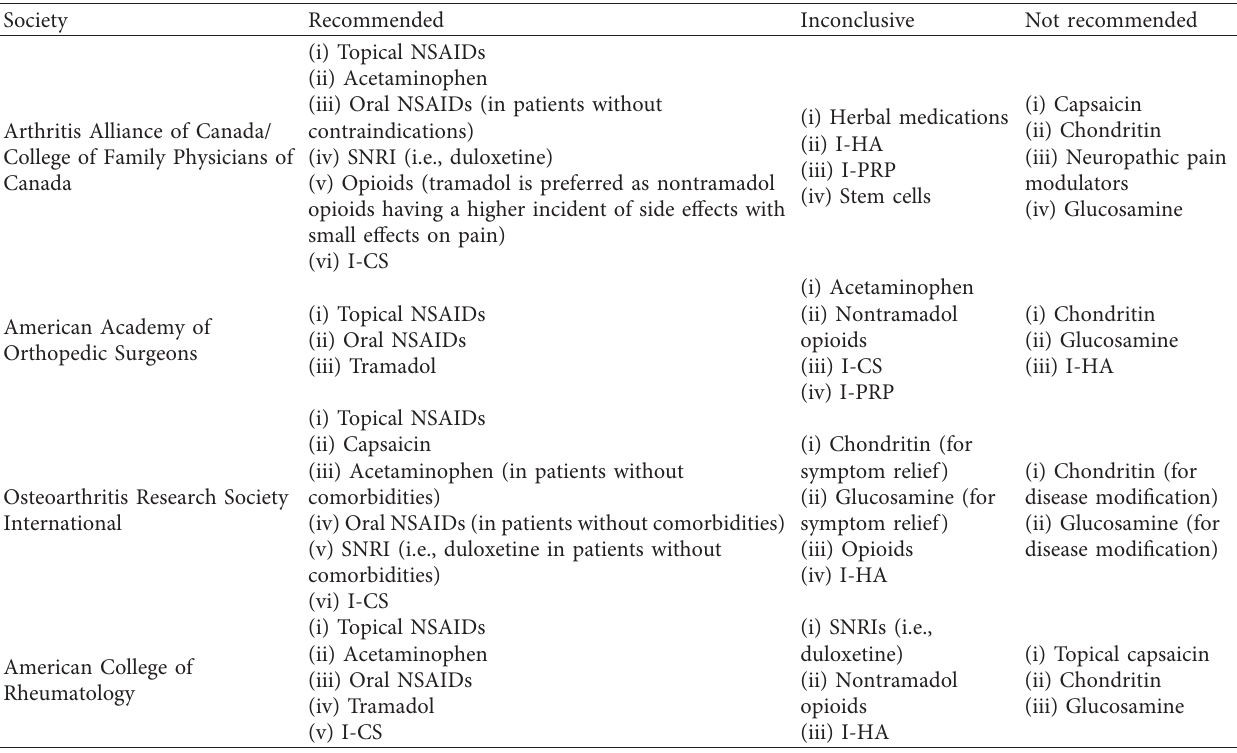
Table 1: Pharmacological and procedural recommendations for treatment of knee